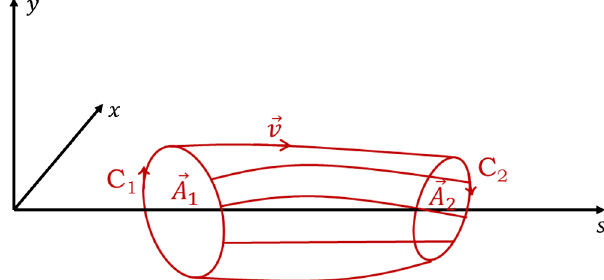
FIG. 1. The contour C encloses possible streams of particle velocities and encloses the area